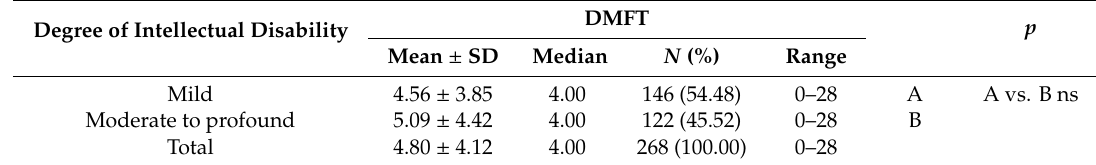
Table 5. Dental caries intensity expressed as DMFT number with respect to degree of intellectual